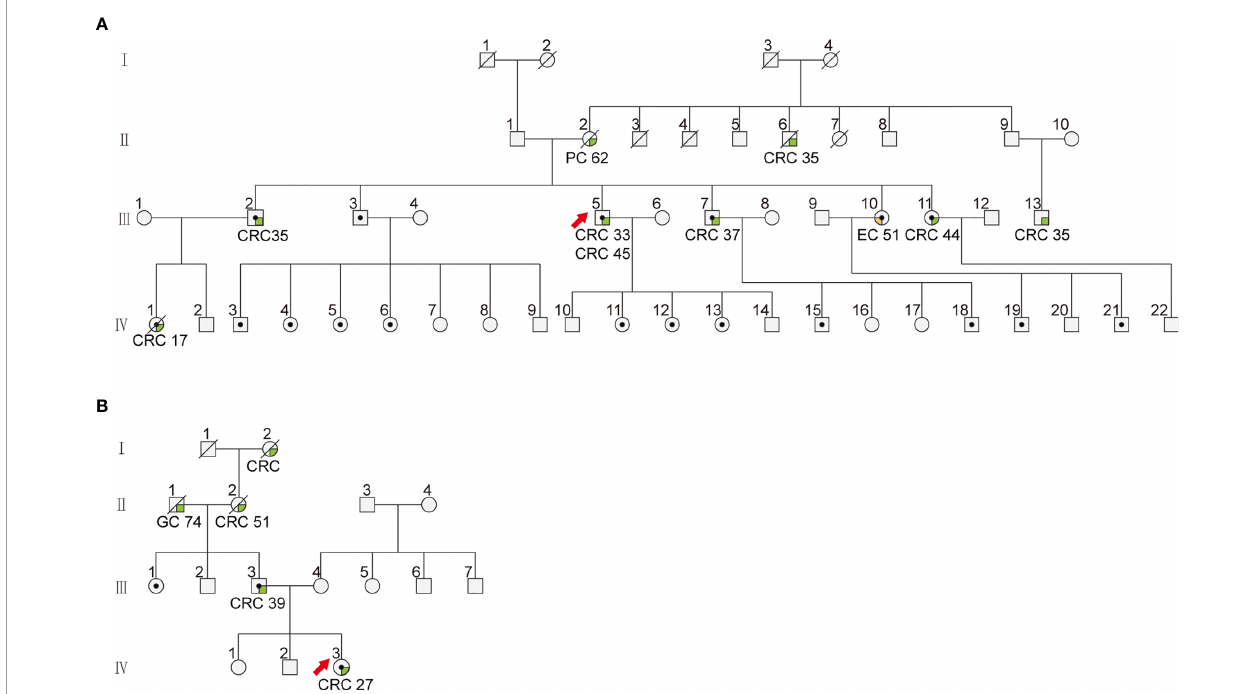
FIGURE 2 | The family pedigree of patients with cytoplasmic staining of MSH2 in colorectal cancer. The family pedigrees of (A) Patient 271 (III5) and 164 (IV1) and (B) patient 345 (IV3) investigated in this study. The proband is indicated by the red arrow. The black dots indicate mutation carriers con fi rmed by genetic testing. The cancer types and age of onset are listed beneath each affected family